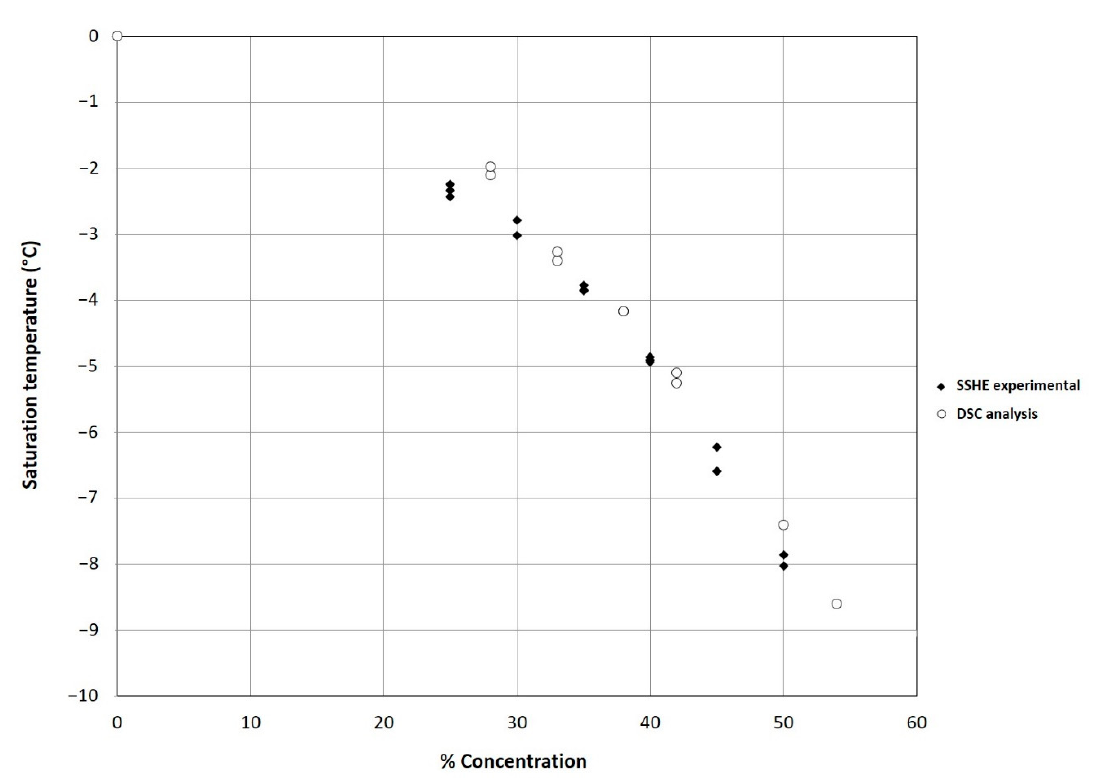
Figure 4. Comparison of experimental T c values obtained in the SSHE and DSC analysis results of the ice cream mixture as a function of solid concentration (%).